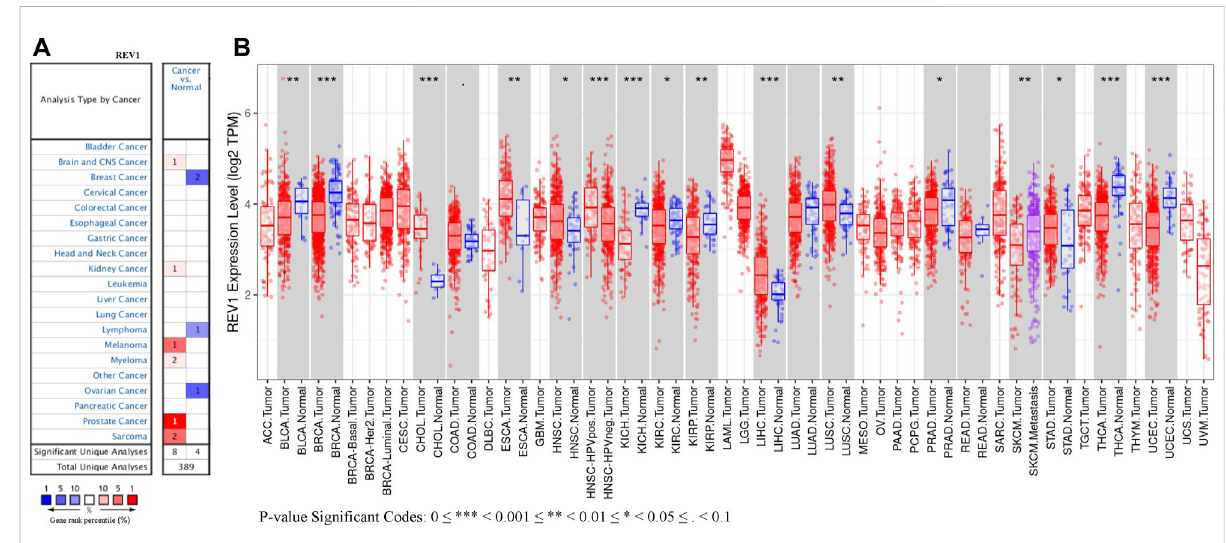
FIGURE 5 The expression level of REV1 in different types of tumor tissues and normal tissues. (A) Oncomine database. (B) TIMER database.